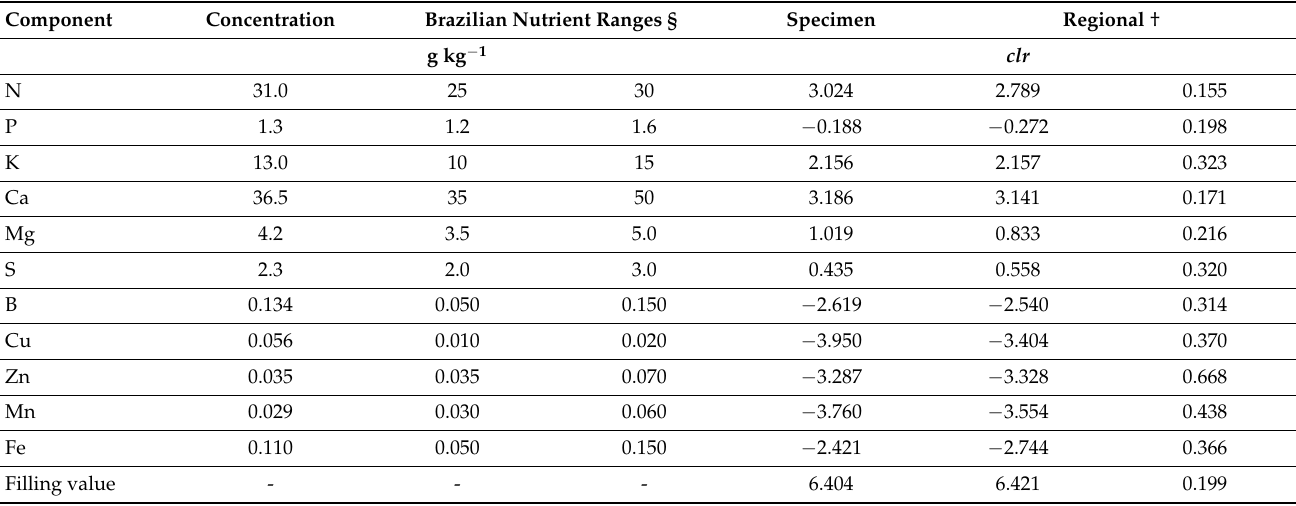
Table 9. Nutrient diagnosis of a defective ‘Val ê ncia’ X ‘Citrumelo Swingle’ specimen.